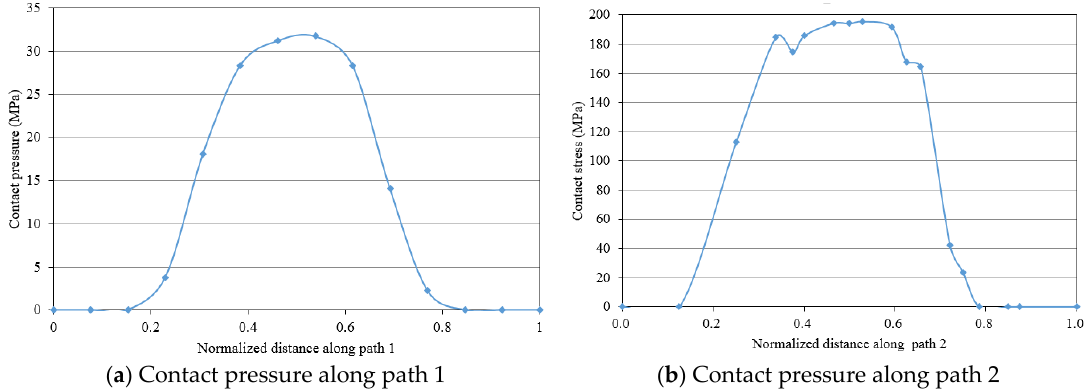
Figure 8. Comparison of the sealing performance along the two paths.